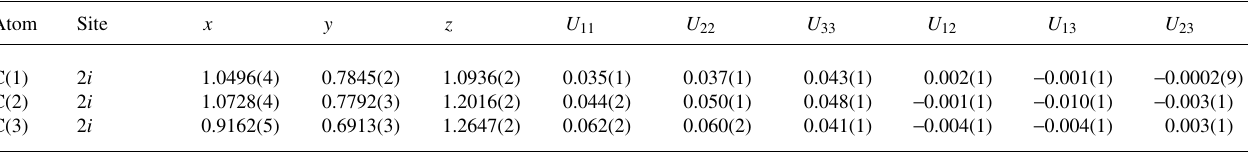
Table 3. Atomic coordinates and displacement parameters (in Å 2 )